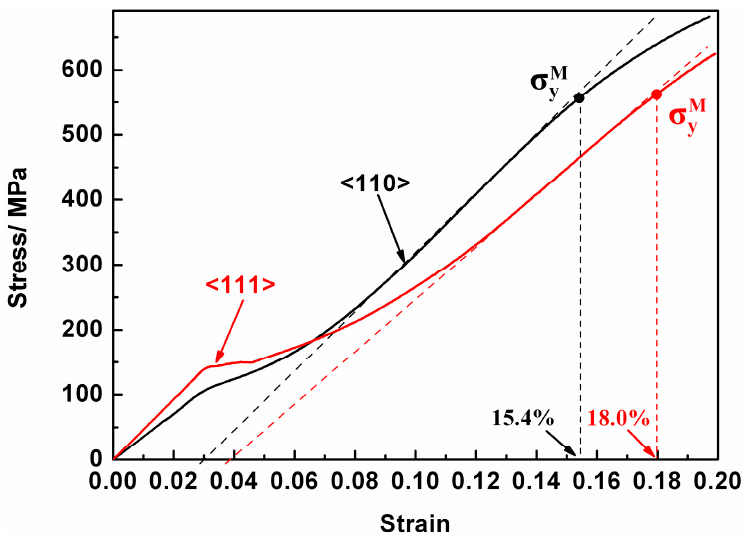
Figure 6. Tensile curves obtained during loading at − 60 °C along the <111> and <110> direction. The martensite yield nominal point is got from the intersection of true stress–strain curve with the martensite elastic stage tangent after 0.2% horizontal movement.